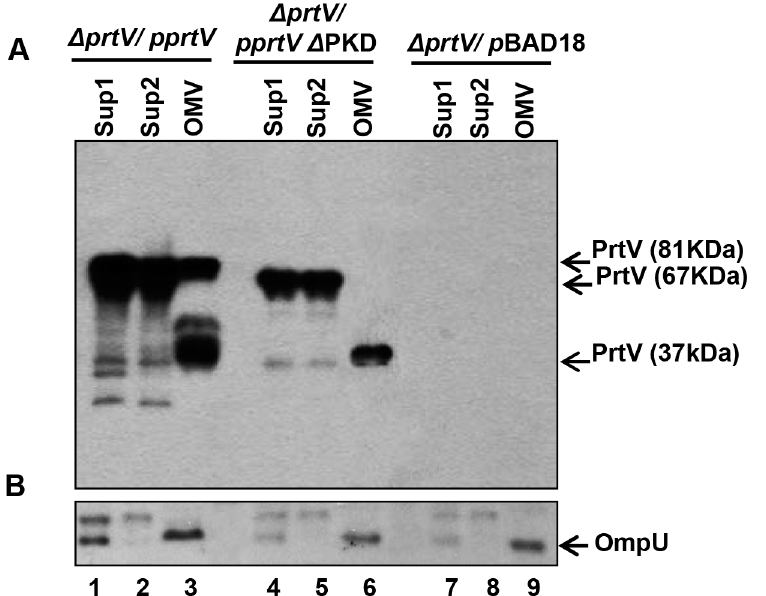
Fig 5. Immunoblot analyses of the wild type PrtV protein and its PKD domain deletion mutant in culture supernatants and OMV samples. Immunoblot analysis was performed using anti-PrtV antiserum (A) and anti-OmpU antiserum (B) with the following samples: lanes 1 – 3: V . cholerae Δ prtV strain carrying the cloned wild type allele of prtV ; lanes 4 – 6: the Δ prtV strain carrying the cloned prtV Δ PKD allele; lanes 7 – 9: the Δ prtV strain carrying the pBAD18 cloning vector. Lanes 1, 4 and 7 were loaded with supernatant samples before ultracentrifugation (Sup1). Lanes 2, 5 and 8 were loaded with the supernatants after ultracentrifugation (Sup2). Lanes 3, 6 and 9 were loaded with the OMV